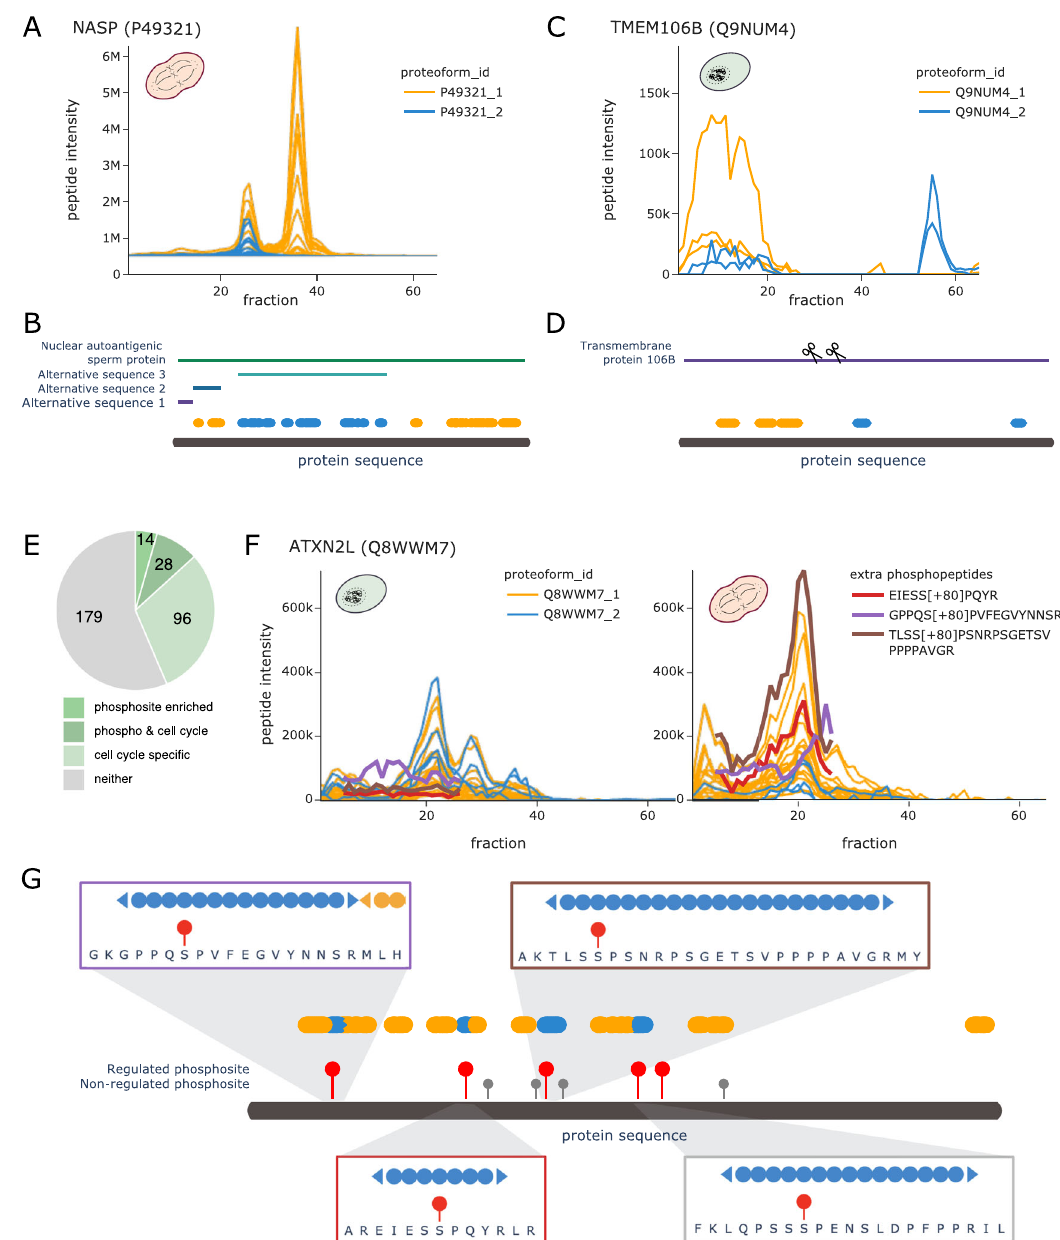
Fig. 5 COPF results for NASP, TMEM106B, and ATXN2L. A Peptide pro fi les of the nuclear autoantigenic sperm protein (NASP, UniProt ID: P49321) in mitosis. Peptides of the two assigned proteoform groups are colored in orange and blue. B Protein sequence plot for NASP. Sequence coverage and position of the detected peptides of the two assigned proteoform groups are indicated in blue and orange. Chain information and alternative sequence isoforms from UniProt are indicated as horizontal bars. C Peptide pro fi les of the transmembrane protein 106B (TMEM106B, UniProt ID: Q9NUM4) in interphase. Peptides of the two assigned proteoform groups are colored in orange and blue. D Protein sequence plot for TMEM106B. Sequence coverage and position of the detected peptides of the two assigned proteoform groups are indicated in blue and orange. Chain information from UniProt is indicated as horizontal bar. Suggested catalytic cleavage sites 45,46 are indicated by scissors. E Pie chart illustrating the number of proteins with a proteoform enriched in cell cycle-regulated phosphosites 35 and their overlap with cell cycle speci fi city of the proteoform. F Peptide pro fi les of the Ataxin-2-like protein (ATXN2L, UniProt ID: Q8WWM7) in interphase (left) and in mitosis (right). Peptides of the two assigned proteoform groups are colored in orange and blue. In addition, traces of subsequently extracted phosphopeptides are highlighted in red, violet, and brown. Please note that the abundance values between the orange and blue peptides cannot be directly compared to the phosphopeptides because of the separate analysis platforms used. G Protein sequence plot for ATXN2L. Sequence coverage and position of the detected peptides of the two assigned proteoform groups are indicated in blue and orange. Cell cycle- regulated phosophosites are indicated by red sticks, whereas non-regulated phosphosites are indicated in gray 35 . Regions of individual phosphopeptides are visualized in separate zoom-in windows, matching the colors of the respective peptides in F